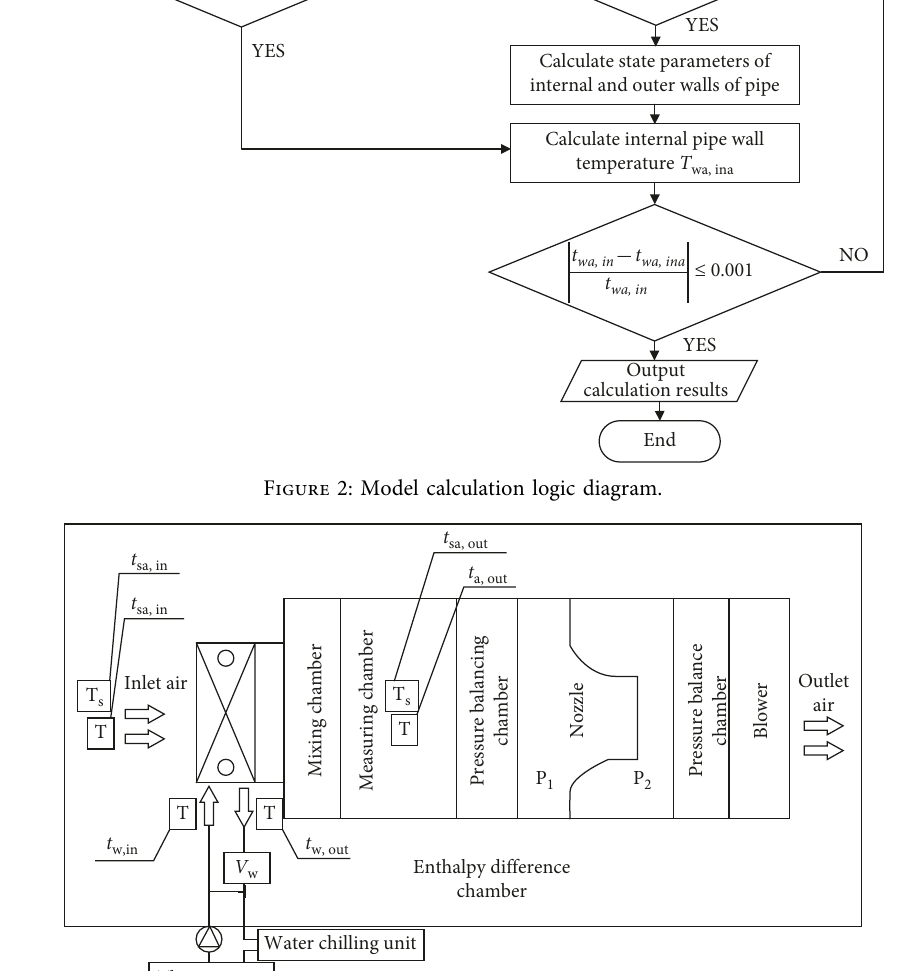
Figure 3: Test point layout of the experimental